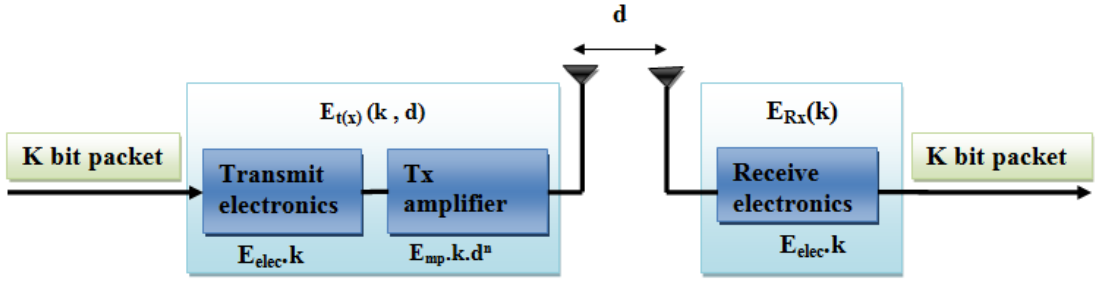
Figure 1. Radio energy dissipation model, adopted from